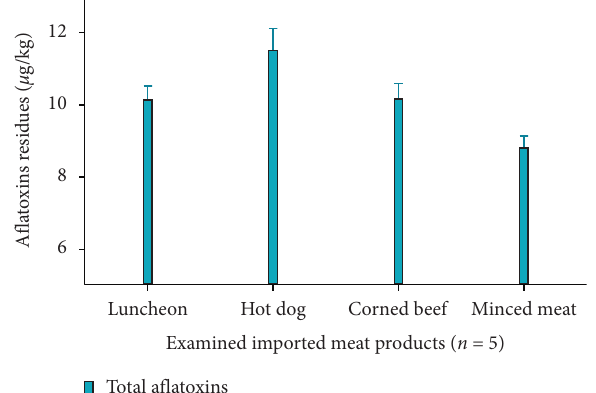
Figure 5: Average of total aflatoxin residues ( µ g/kg) in examined imported meat products.